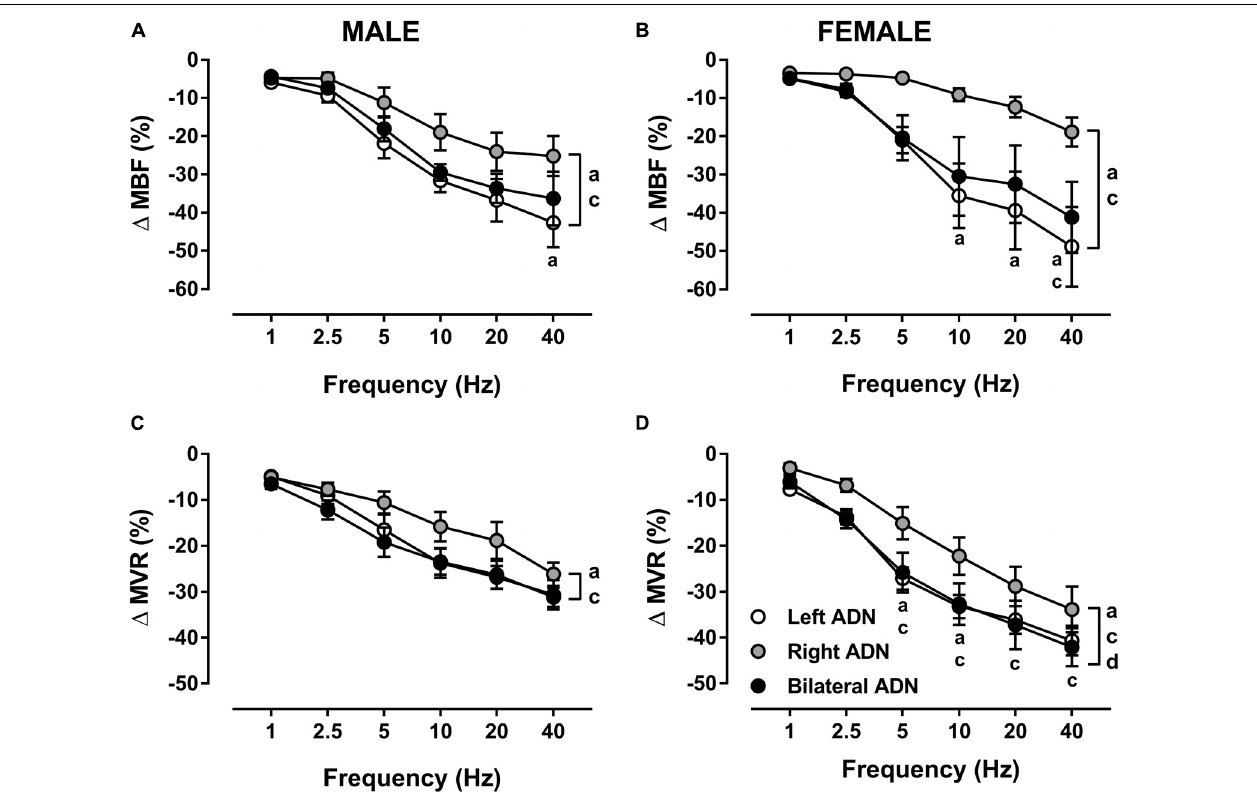
FIGURE 5 | Effects of left, right and bilateral aortic depressor nerve (ADN) stimulation (1–40 Hz, 0.4 mA, 0.2 ms, 20 s) on mesenteric blood flow (MBF) (A,B) and mesenteric vascular resistance (MVR) (C,D) responses in urethane-anesthetized male (left panels) and female (right panels) Sprague Dawley (SD) rats ( n = 6–9). Results are expressed as mean ± SEM. a P ≤ 0.05, left vs. right ADN, c P ≤ 0.05, right vs. bilateral ADN and d P ≤ 0.05, female vs. male for respective left and bilateral ADN analyzed by a two-way ANOVA followed by Bonferroni’s post hoc . Note that, in both males and females, left and bilateral stimulation evoked the greatest drops (both overall and variably at frequencies ranging between 5 and 40 Hz) in MBF and MVR. Females’ left and bilateral stimulation showed greater reflex reductions in MVR compared with those of the males’